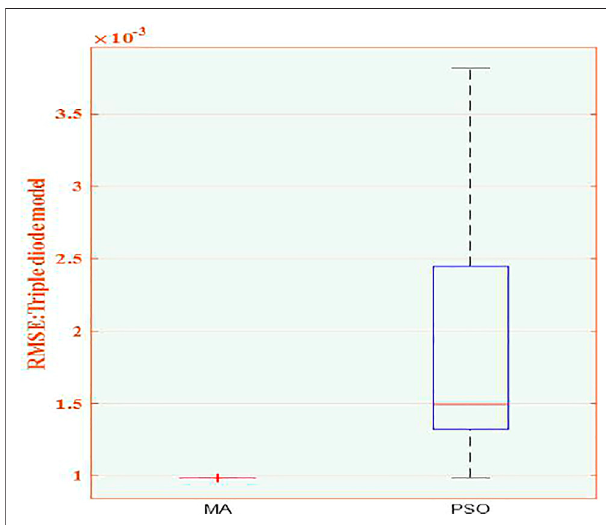
FIGURE 2 | Boxplot of the RMSE obtained by two algorithms for the TDM.